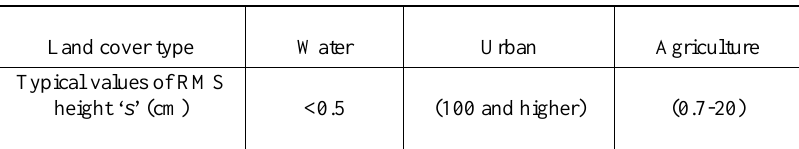
Table 3. Typical range of RMS height for major land